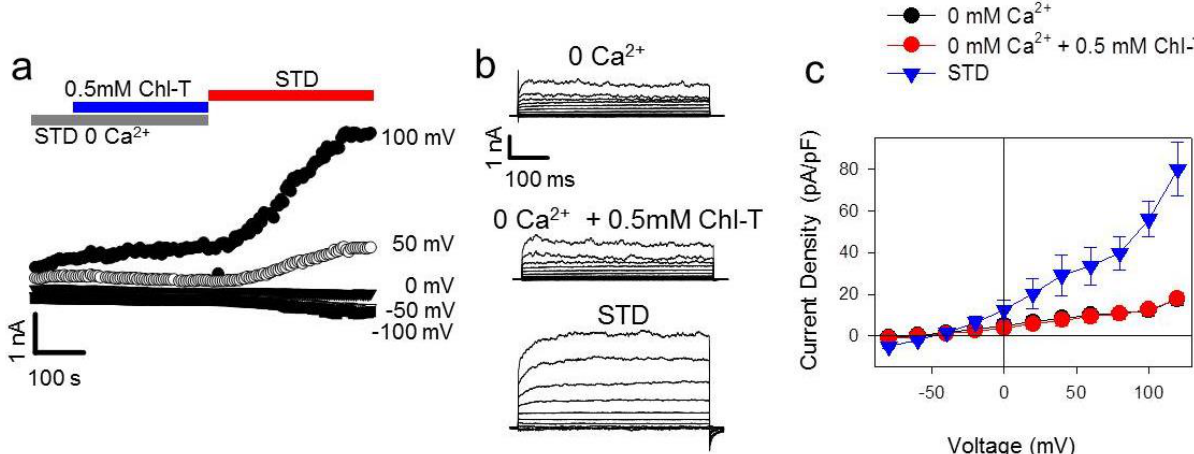
Figure 6. Application of Chl-T in the absence of extracellular Ca 2+ does not activate K + currents in IGR39 cells. ( a ) Time course of currents elicited in a representative IGR39 cell during the application of 0.5 mM Chl-T in 0-Ca 2+ solution and subsequent application of STD solution. ( b ) Current traces before Chl-T application (left), during application in 0 Ca 2+ (middle), and after perfusion with STD solution (right) (normalized Chl-T response in STD 0 Ca 2+ solution at 100 mV = 1.08 ± 0.04, p = 0.7, n = 5; current fold increase after STD application 2.02 ± 0.22, p = 0.004, n = 4) ( c ) Current density–voltage relationship for IGR39 cells after the application of Chl-T in the absence of extracellular Ca 2+ , and subsequent STD administration. Data are expressed as mean ± SEM from 5 independent experiments. Vhold = − 50 mV.